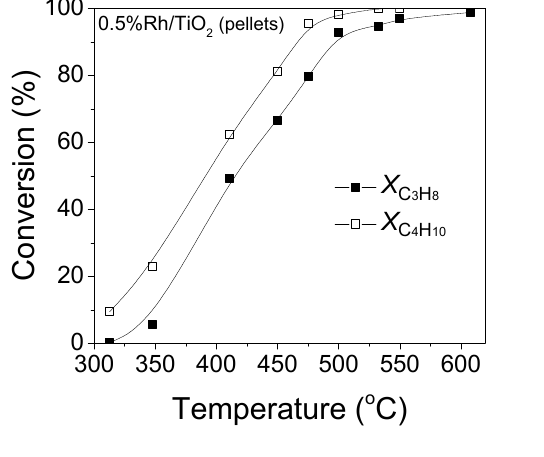
Figure 13. Long-term stability test of 0.5%Rh/TiO 2 catalyst in the form of pellets at T = 550 and 500 °C: Alterations of the conversion of C 3 H 8 and C 4 H 10 , and selectivities toward reaction products with time-on-stream. Experimental conditions: Same as in Figure 12. Dashed vertical black lines indicate shutting down of the system overnight. Dashed vertical red line indicates switch of temperature from 550 to 500 °C.